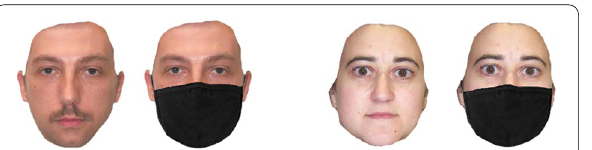
Fig. 3 Gender stimuli of neutral expression with or without mask were used in the gender classification task